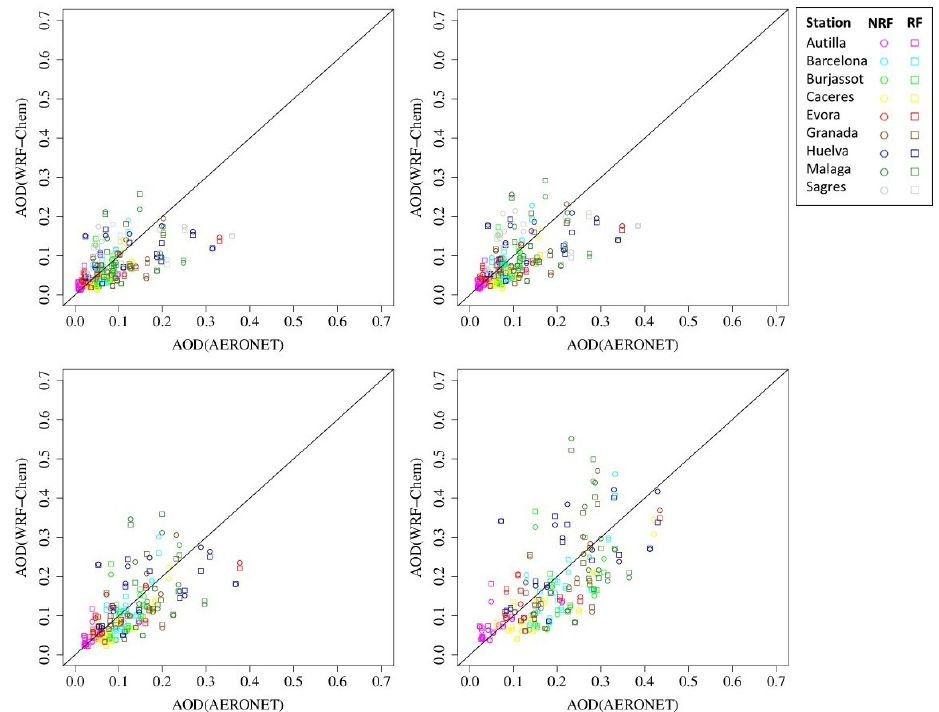
Figure 9. As Fig. 8 but for the fire episode (from 25 July to 7